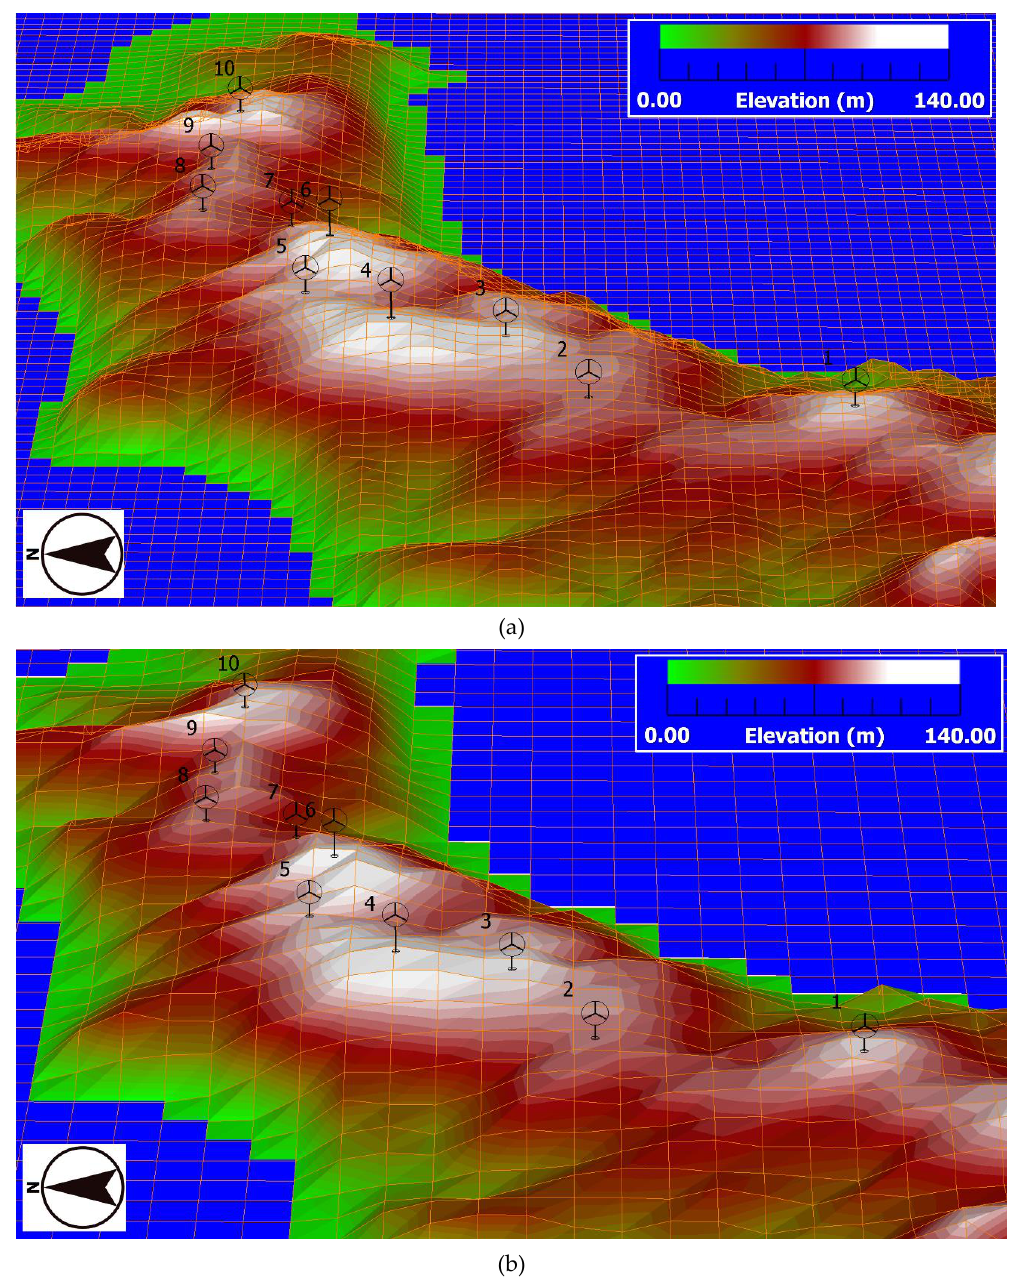
Figure 29. Comparison of the horizontal grid resolution—(a) 25 m, and (b) 50 m. Figure A1. Comparison of the horizontal grid resolution—( a ) 25 m, and ( b ) 50